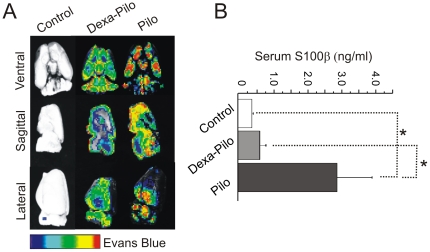
Dexamethasone reduces BBB damage in pilocarpine-treated rats.BBB integrity was assessed by Evans blue (A) and serum S100β (B) measurements. Evans blue is an indicator of paracellular leakage while S100β is a surrogate serum marker of the integrity of the cerebrovascular endothelial interface. Both methods revealed a reduction of pilocarpine-induced BBB damage in dexamethasone-pretreated animals (DEXA-PILO). Similar efficacy was previously reported for IL1-RA (see [29]). The asterisks refers to p<0.05 by paired t-test, n = 5 rats per group.